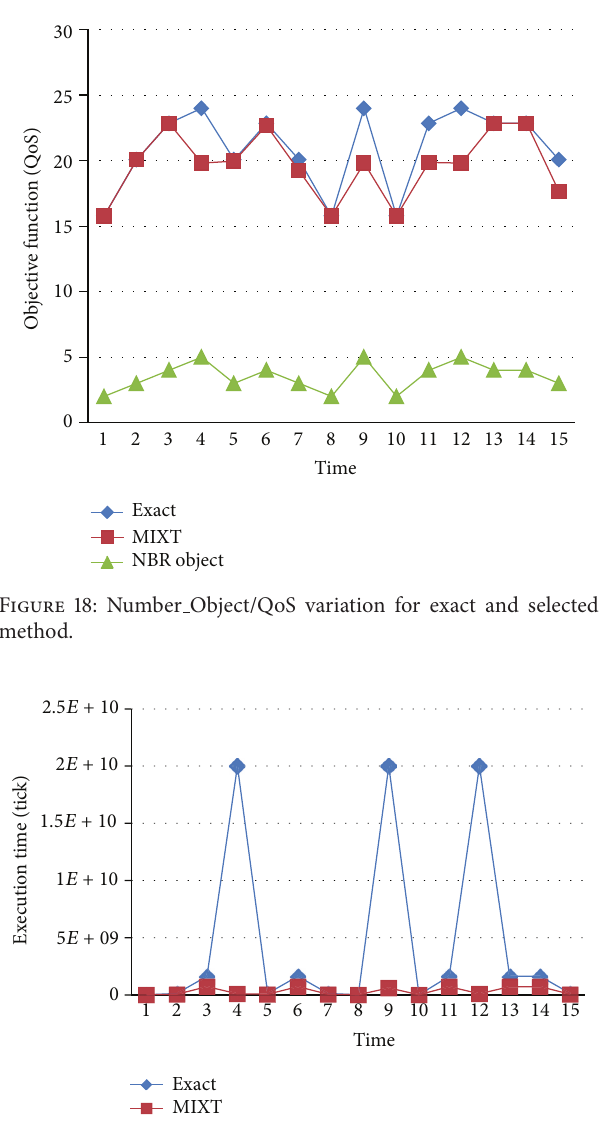
Figure 19: Number Object/ 𝑇